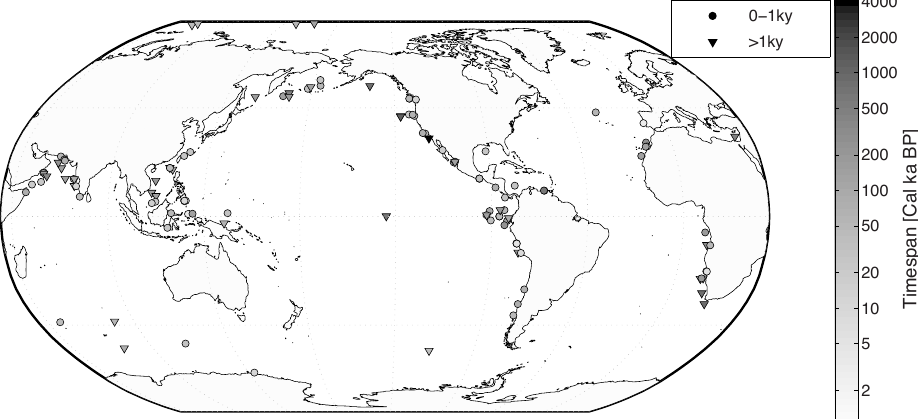
Fig. 3. Locations of cores with a δ 15 N record versus age. Each symbol represents a core site. The δ 15 N records of each site differ both in their time ranges and in the resolution of their data. The shaded symbols indicate the timespan (CalkaBP). We categorized records with high (circles) and low temporal resolution (triangles). High temporal resolution is considered to be an average sampling frequency of at least one data point every ky, whereas low resolution is everything longer than this